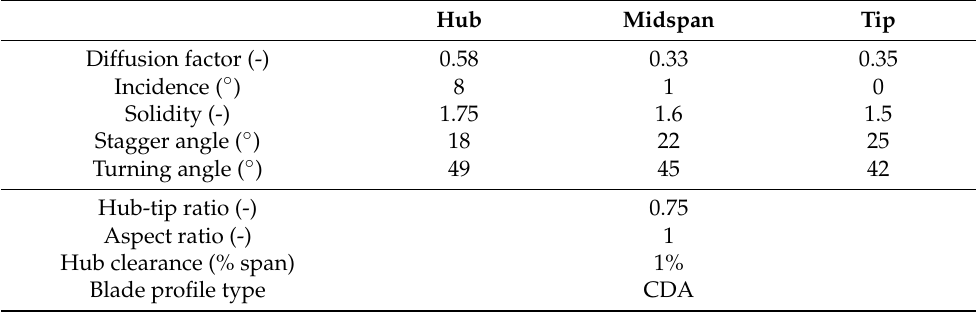
Table 3. Design parameters for the highly loaded cantilevered stator.